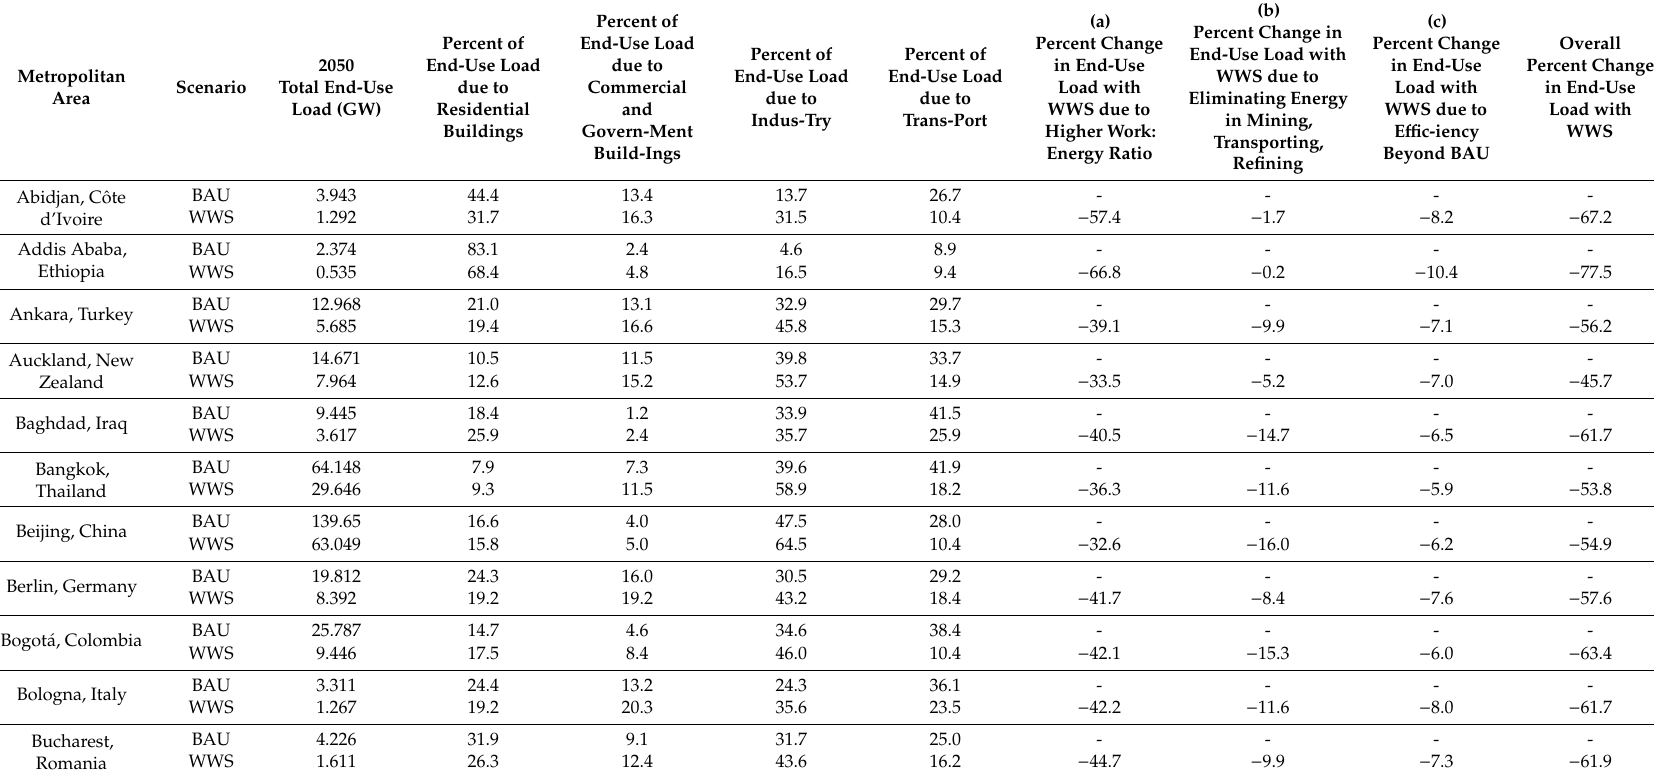
Table 1. Business-as-usual (BAU) and wind, water, and sunlight (WWS) end-use energy load by sector and city. First row for each city: Estimated 2050 total annually averaged end-use load (GW) and percent of the total load by sector if conventional fossil fuel, nuclear, and biofuel use continue from today to 2050 under a BAU trajectory. Second row for each city: Estimated 2050 total end-use load (GW) and percent of total load by sector if 100% of BAU end-use all-purpose delivered load in 2050 is instead provided by WWS. The last four columns show the percent reductions in total 2050 BAU load due to switching from BAU to WWS, including the e ff ects of ( a ) energy use reduction due to the higher work-to-energy ratio of electricity over combustion, ( b ) eliminating energy use for the upstream mining, transporting, and / or refining of coal, oil, gas, biofuels, bioenergy, and uranium, and ( c ) policy-driven increases in end-use e ffi ciency and demand reduction beyond those in the BAU